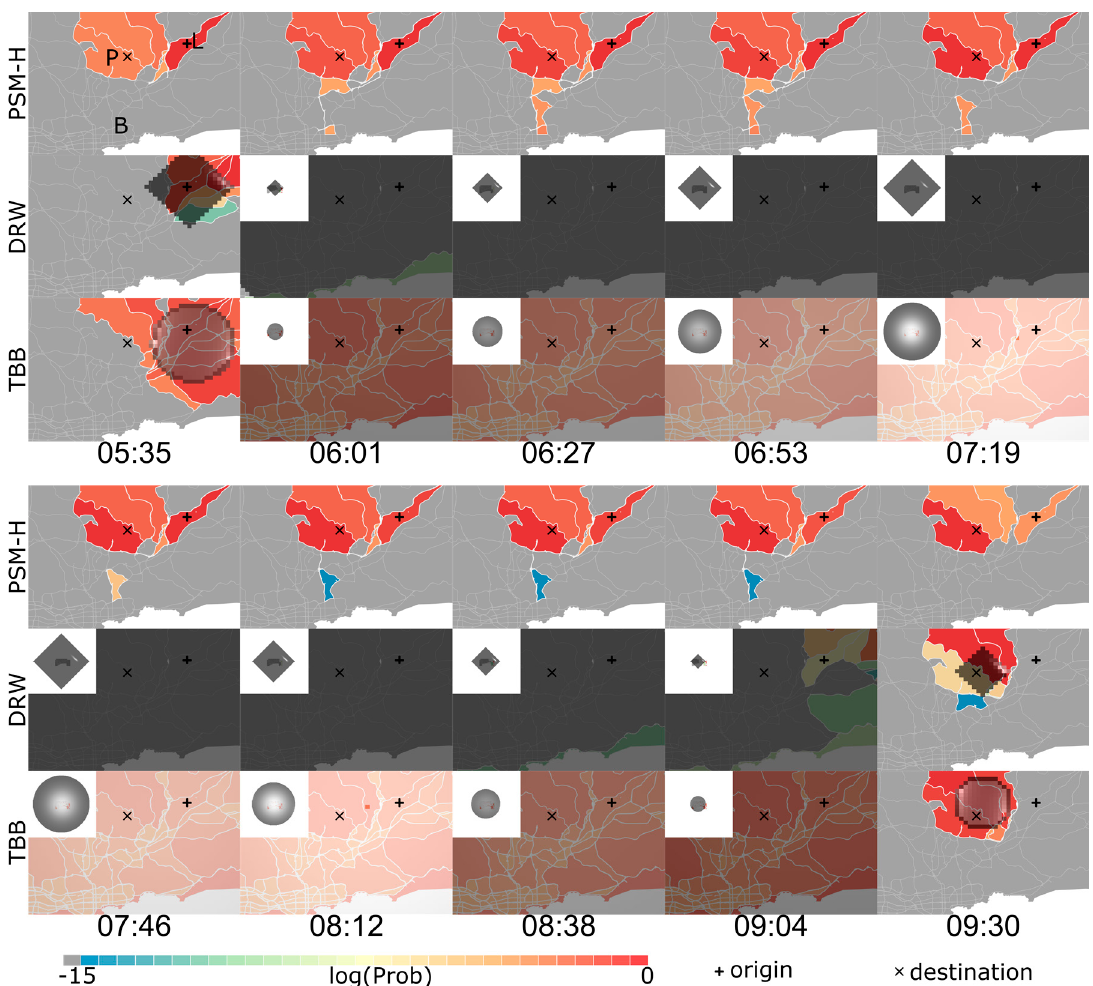
Figure 5. The visit probability distributions by four models during a trajectory gap involving an urban trip. There are ten groups of snapshots of the dynamic probability distribution. The extent of each snapshot is 22.52N to 22.79N, and 113.94E to 114.34E, while that of each inset is 20.84N to 24.57N, and 112.11E to 116.27E.